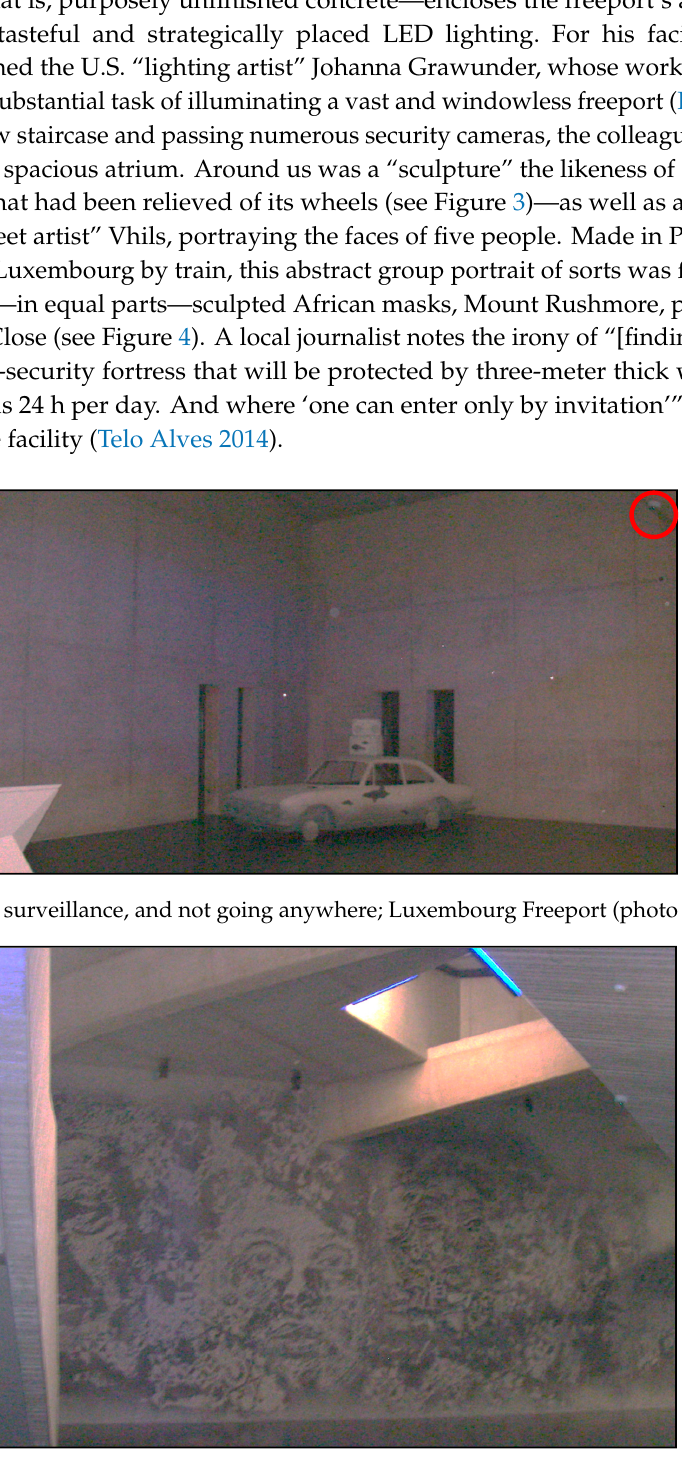
Figure 4. Street art, without the street; Luxembourg Freeport (photo by the author).